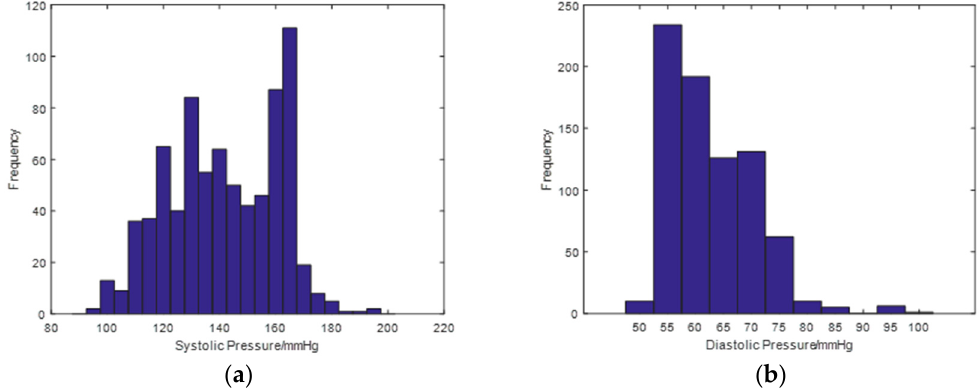
Figure 1. ( a ) Distribution of systolic blood pressure. ( b ) Distribution of diastolic blood pressure.